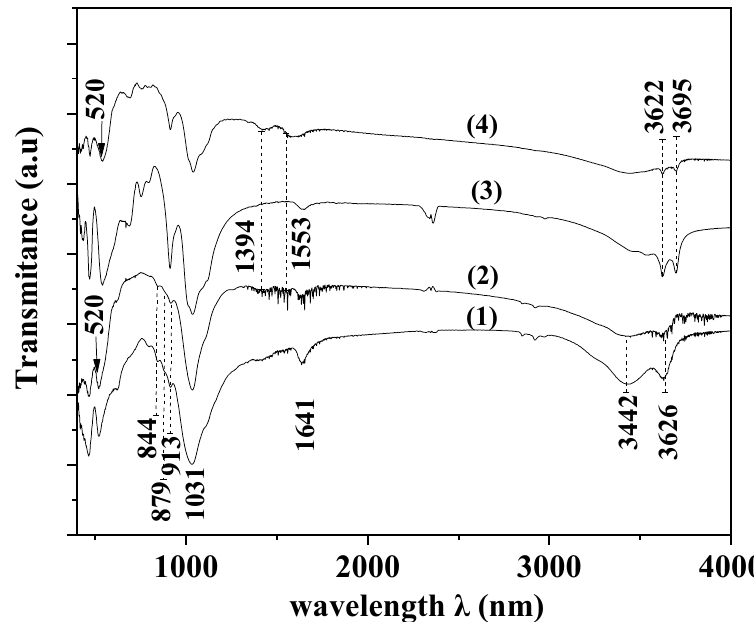
Figure 3. FTIR plots of pure Mt (1), ZnO@Mt nanohybrid (2), pure HNT (3), and ZnO@HNT nano ‐ hybrid (4).